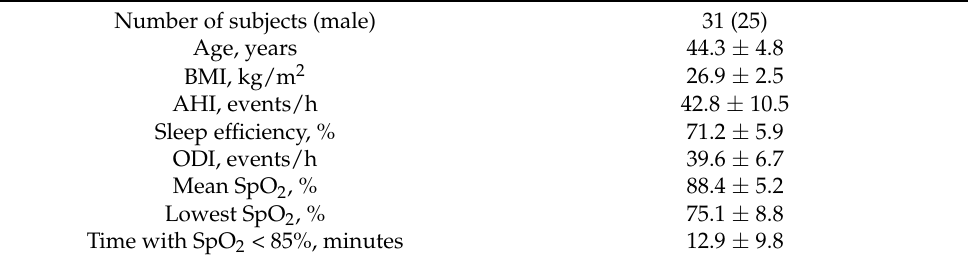
Table 1. Demographic data and polysomnography parameters of the enrolled OSA patients.